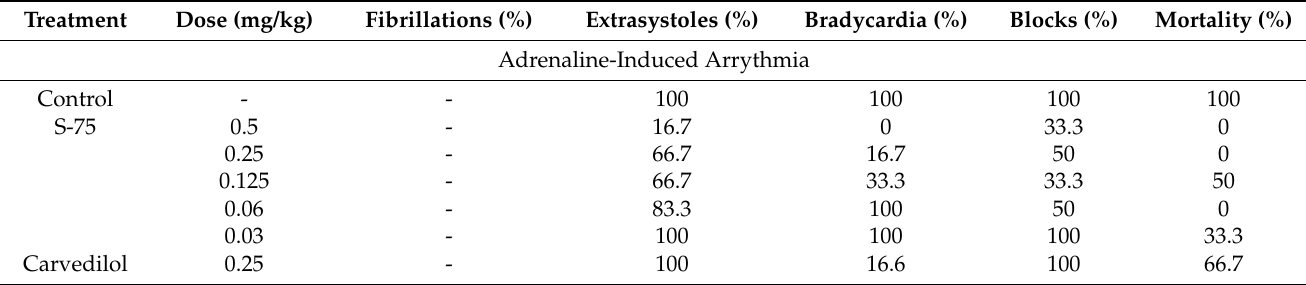
Table 3. The effect of the tested compound on chosen parameters in arrythmia models in rats. Treatment